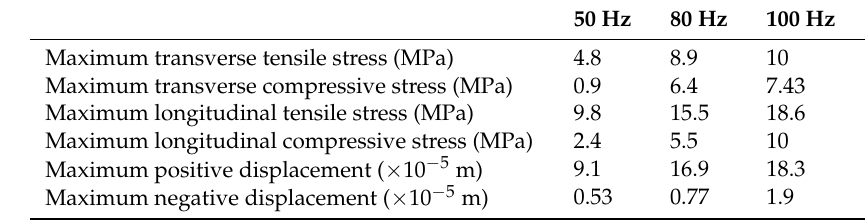
Table 2. Stress and displacement of the mid-point of the weld at different